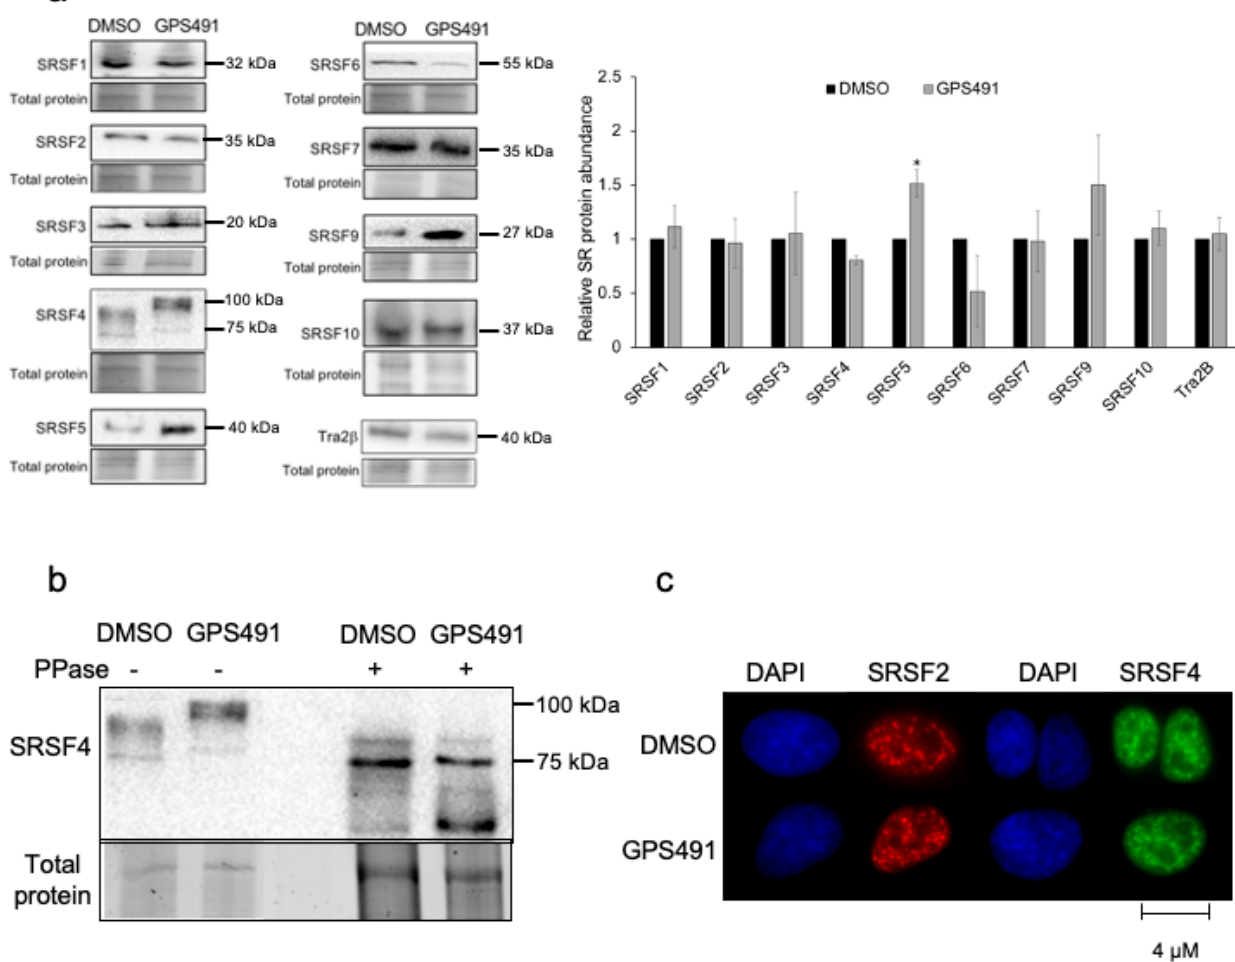
Figure 6. GPS491 alters expression and phosphorylation of selected SR proteins. HeLa rtTA HIV ∆ mls cells were treated with DMSO or GPS491 (2.5 µM) and induced with Dox. Twenty hours post induction, cells were harvested in RIPA buffer containing a phosphatase inhibitor cocktail and fractionated on 10% stain-free SDS-PAGE gels. ( a ) Representative Western blots for each SR protein are shown. At the right, a summary of Western blots from three independent assays measuring the effect of GPS491 on SR proteins levels relative to DMSO-treated cells. Asterisks (*) represent changes in expression level at p < 0.05. ( b ) Cell lysates were mock-treated or treated with alkaline phosphatase (PPase) prior to loading onto 10% stain-free gels. After transfer onto PVDF, blots were probed for SRSF4. Blots are representative of n > 3 independent assays. ( c ) Cells treated with DMSO or GPS491 were fixed and permeabilized followed by staining with antibodies to either SRSF2 or SRSF4. DAPI was used to stain for cell nuclei. Images were captured on Leica DMR Microscope at 63× oil immersion. To evaluate the effect of GPS491 on SR function, we also examined whether the compound altered SR protein activity as measured by their modulation of Bcl-x RNA splicing. In this instance, cells were transfected with a Bcl-x reporter vector (Bcl-x 2.13, Figure 7a) along with control vector plasmids (CTRL, CMVmyc) or ones expressing individual SR proteins. As indicated in Figure 7c and Supplementary Figure S3a, plasmid- derived expression of most SR proteins in the absence of the compound decreased the use of the Bcl-xS 5 ′ ss, only transfection of SRSF10 yielding the opposite effect. The addition of 10 µM GPS491 had a limited or no effect on the response to most SR proteins tested (Figure 7c), except for SRSF10, where it decreased the ability of SRSF10 to promote Bcl-xS 5 ′ ss